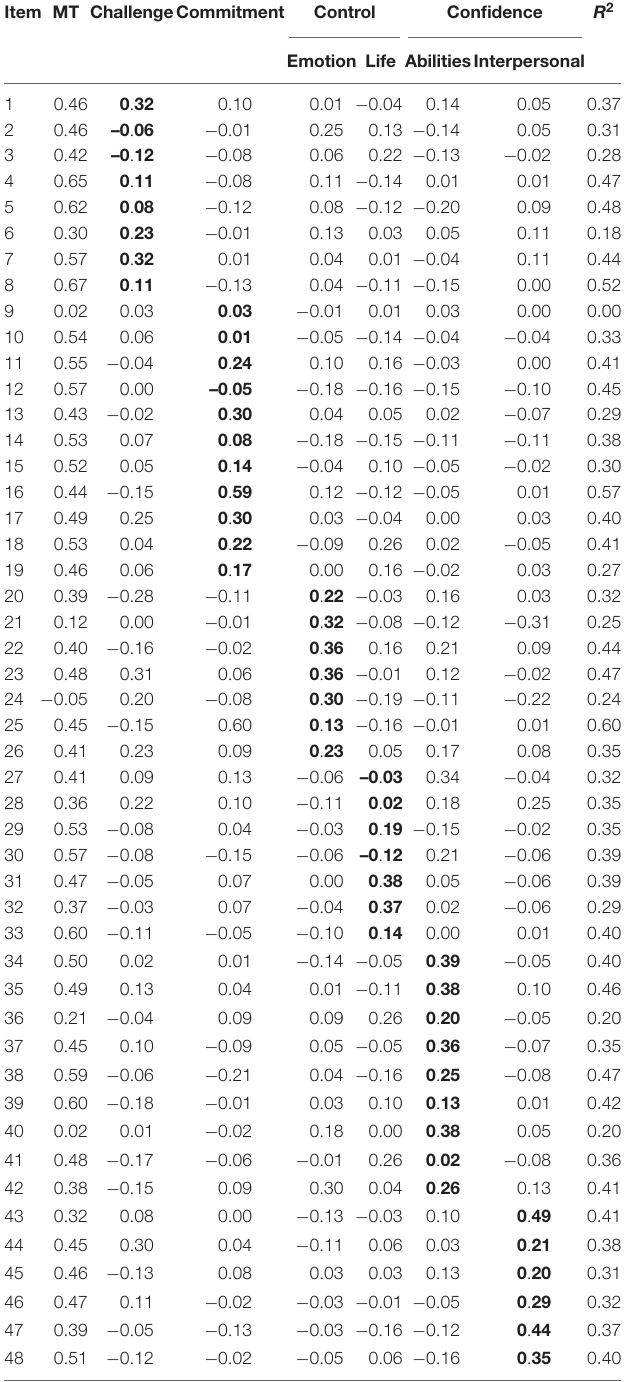
TABLE 3 | Factor loadings for bifactor model with target